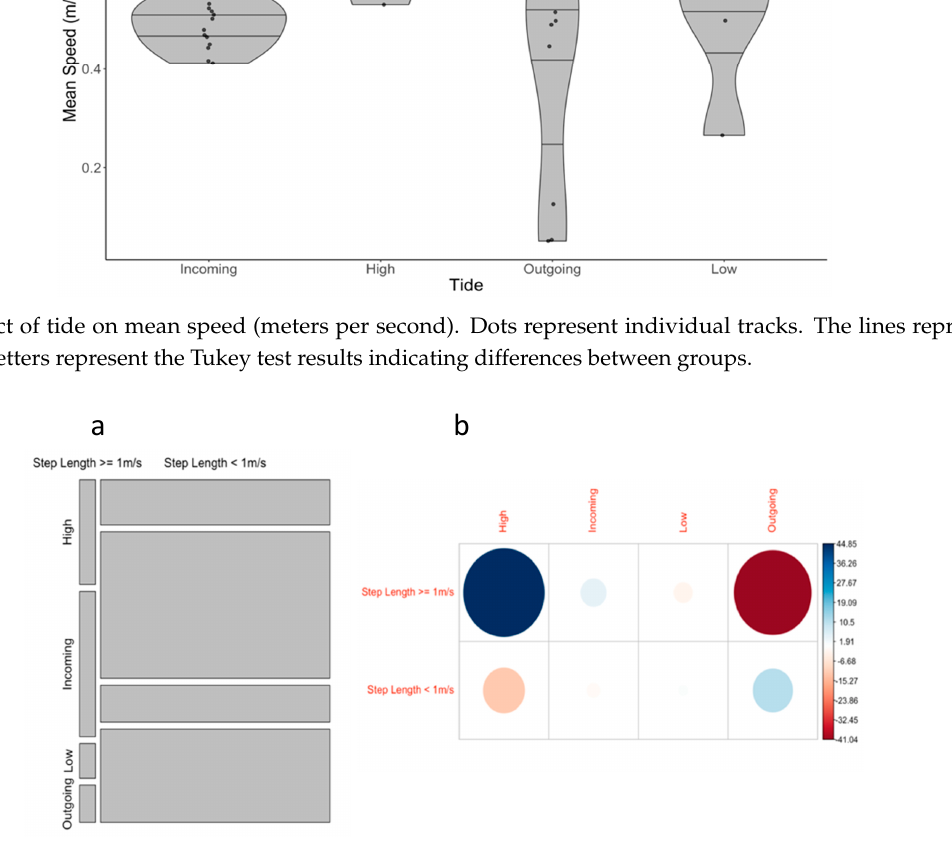
Figure 10. ( a ) A mosaic plot comparing proportions of step length above and below 1 m/s according to tide. The ‘x’ axis compares the proportions of the total number of step lengths above and below 1 m/s for all tides. The ‘y’ axis compares the proportion of the total number of step lengths above and below 1 m/s for each tide. ( b ) A balloon plot indicating the relationship between proportions of step length above and below 1 m/s according to tide. The larger the circle and darker the color, the greater the residuals and the stronger the correlation. Blue represents a positive correlation, while red represents a negative correlation.